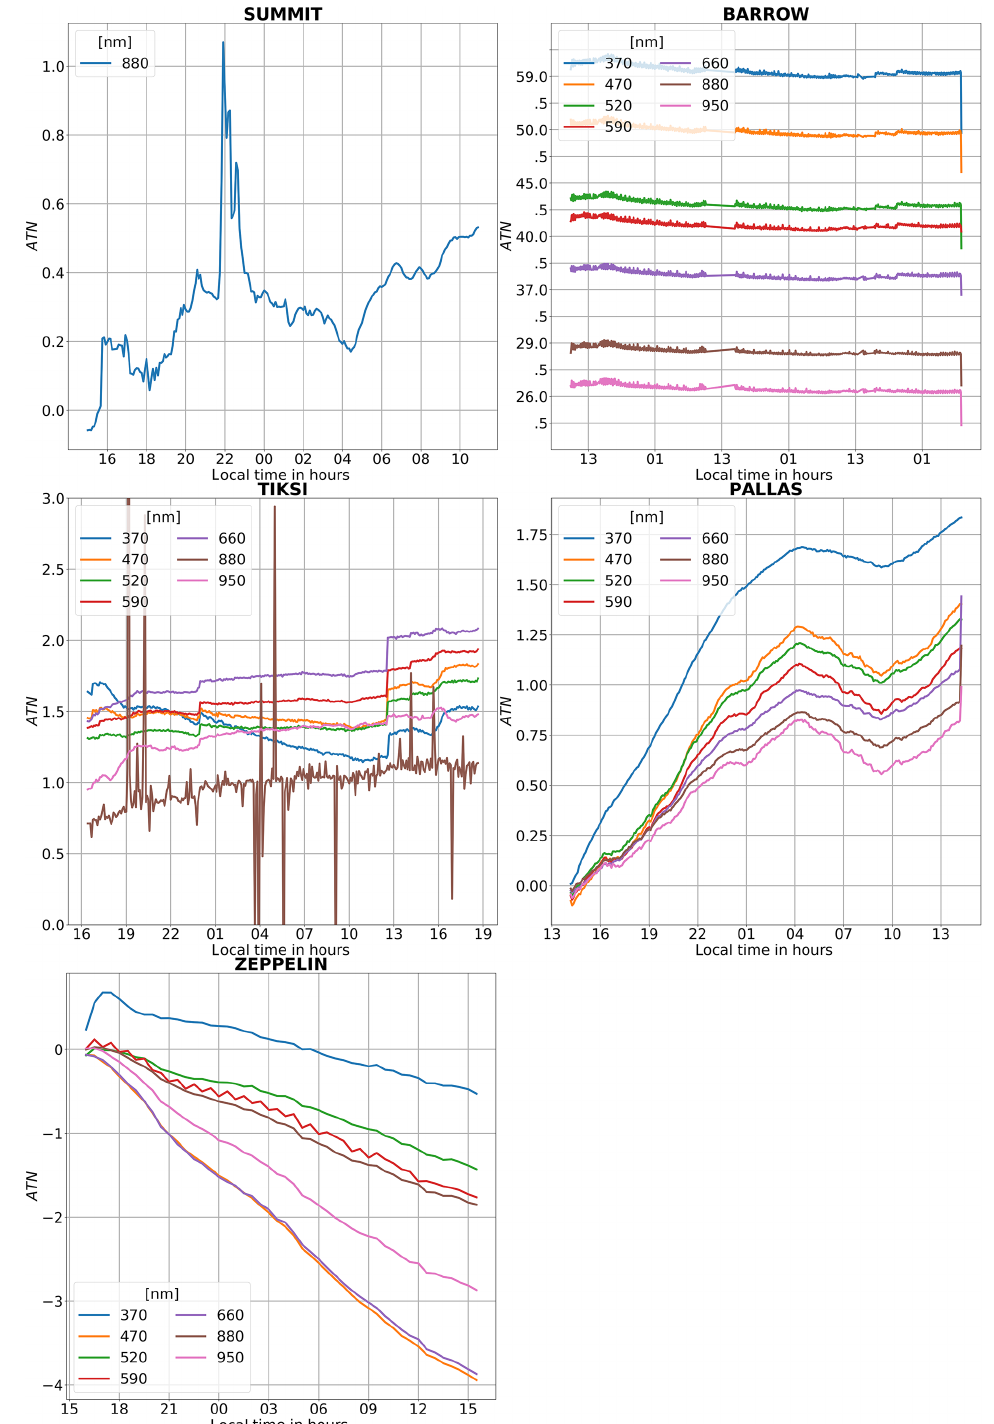
Figure A2. ATN for all wavelengths from the measurements with absolute filters connected to the sample inlet. Alert is not shown because the measurements were not conducted for more than a few hours although they were conducted